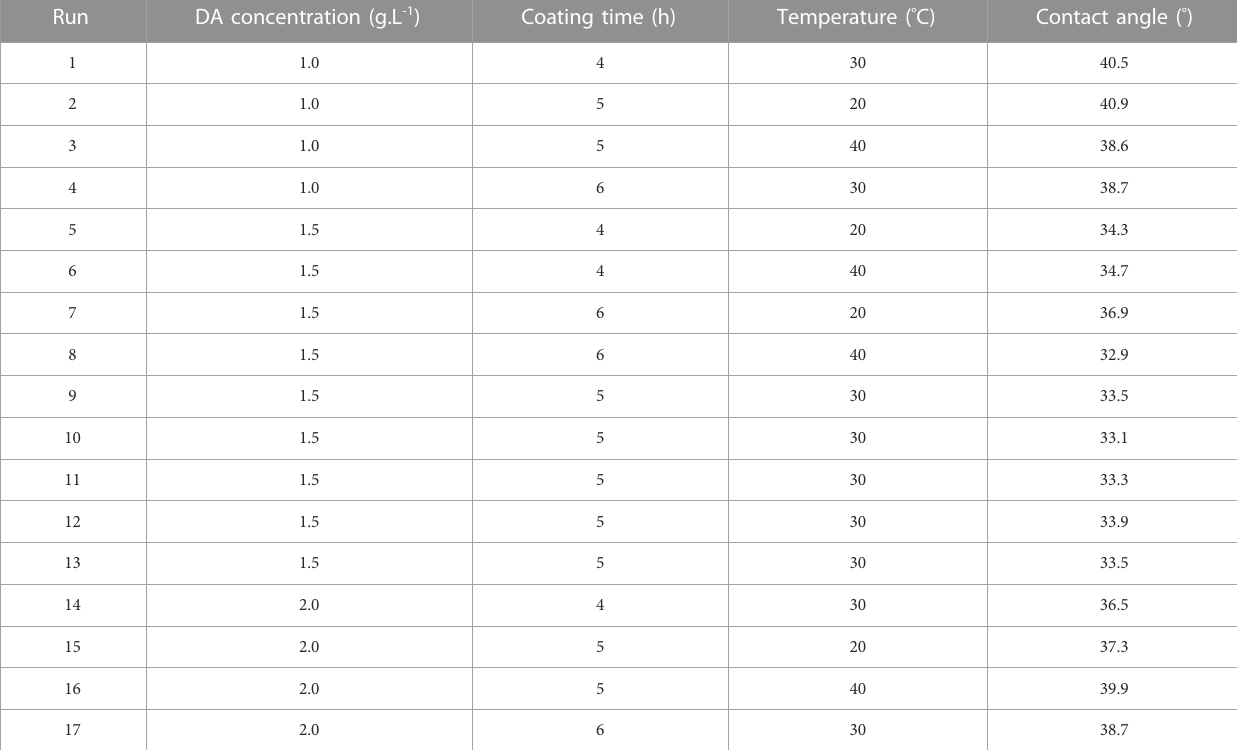
TABLE 2 Response surface optimization experimental scheme and results.